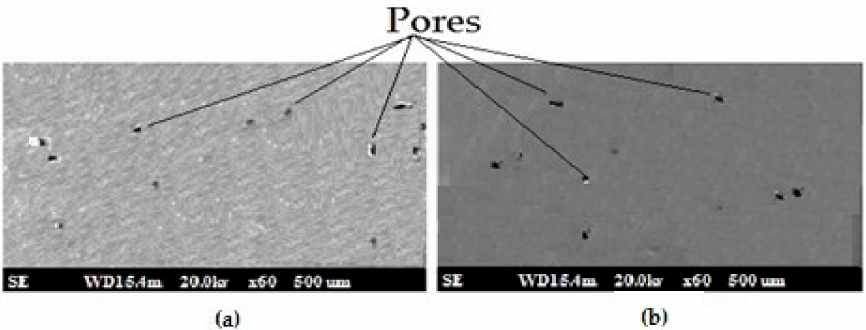
Figure 2. Presentation of recycled alloy ( a ) condition before heat treatments ( b ) condition after heat